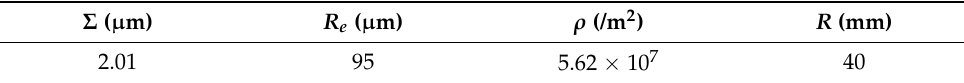
Table 1. Surface contact model parameters of